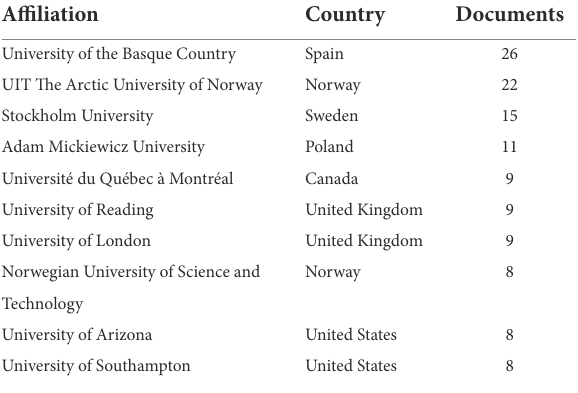
TABLE 2 Information on the first ten most productive affiliations ordered by the number of total publications: Affiliation, the country it belongs to, and the total number of